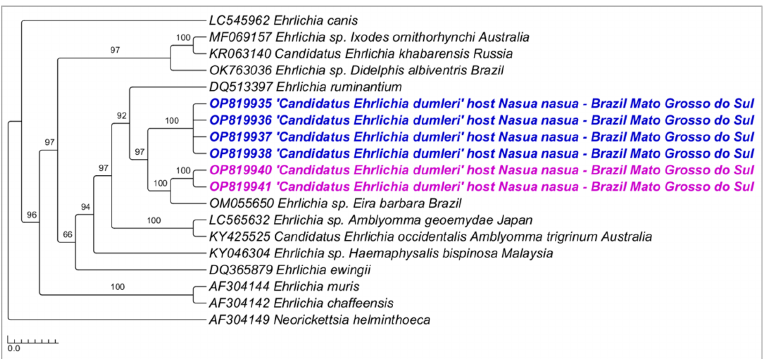
Figure 6. Phylogenetic tree inferred by the Bayesian method and based on the gltA gene from Ehrlichia spp. sequences obtained from blood from ring-tailed coatis ( Nasua nasua ) sampled in Campo Grande city, Mato Grosso do Sul state, Brazil. Sequences detected in the present study are highlighted in bold pink (VBA) and blue (PEP). In order to evaluate the genetic distance between the two Ehrlichia sp. sub-clades detected in the present study (PEP x VBA), median joining network (MJN) and haplotype analyses with fourteen 16S rRNA sequences that clustered together or in a clade near those sequences detected in coatis (Table 3, Figure 7) was performed. As a result, seven genotypes were found with 34 variable sites. In the MJN analysis, sequences detected in coatis from VBA and the one detected in E. barbara , Mato Grosso, Brazil (MZ130191) were represented by the same haplotype (haplotype #4). On the other hand, sequences de-